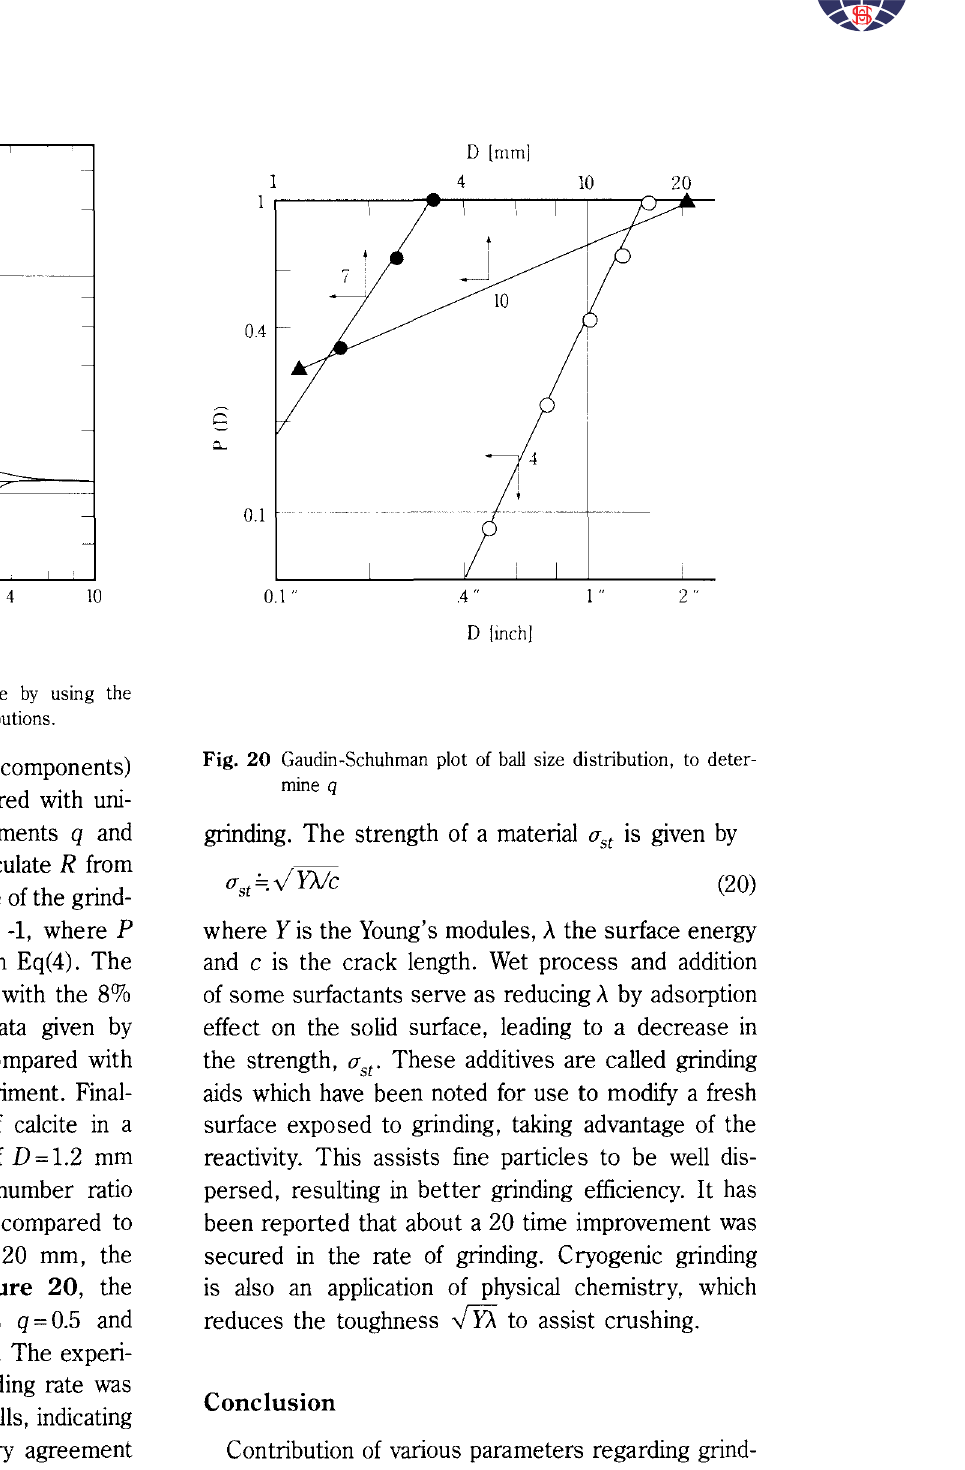
Fig. 19 Calculated improvement of grinding rate by using the composite ball size of various size distributions.